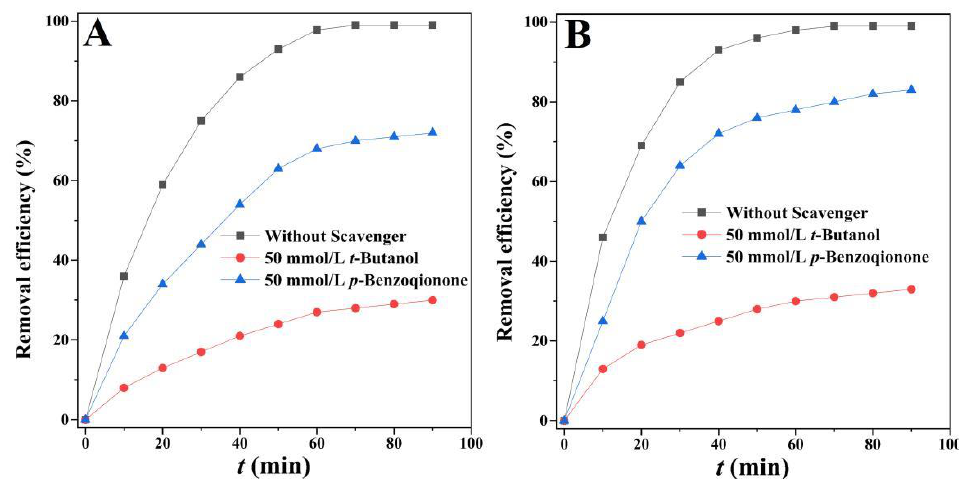
Figure 11. Effect of radical scavenger on the removal efficiency of ( A ) MG and ( B ) TH.